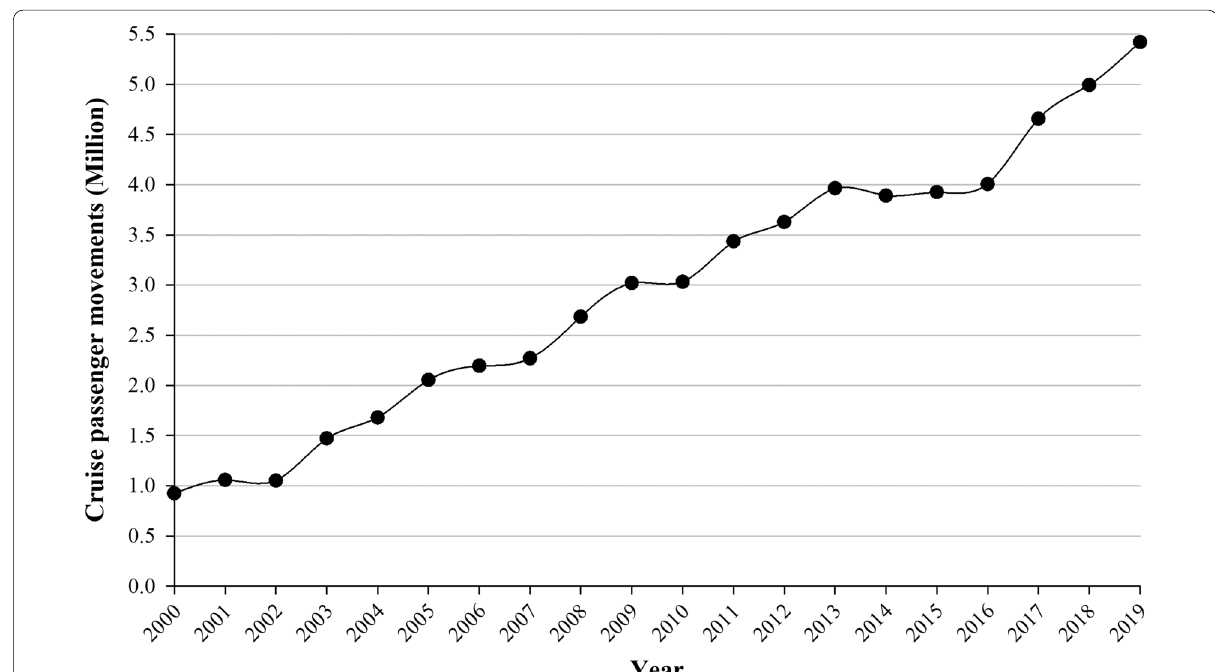
Fig. 1 Evolution of cruise passenger movements in the Baltic Sea during the period from 2000 to 2019. Source : Author’s elaboration based on data from Cruise Baltic